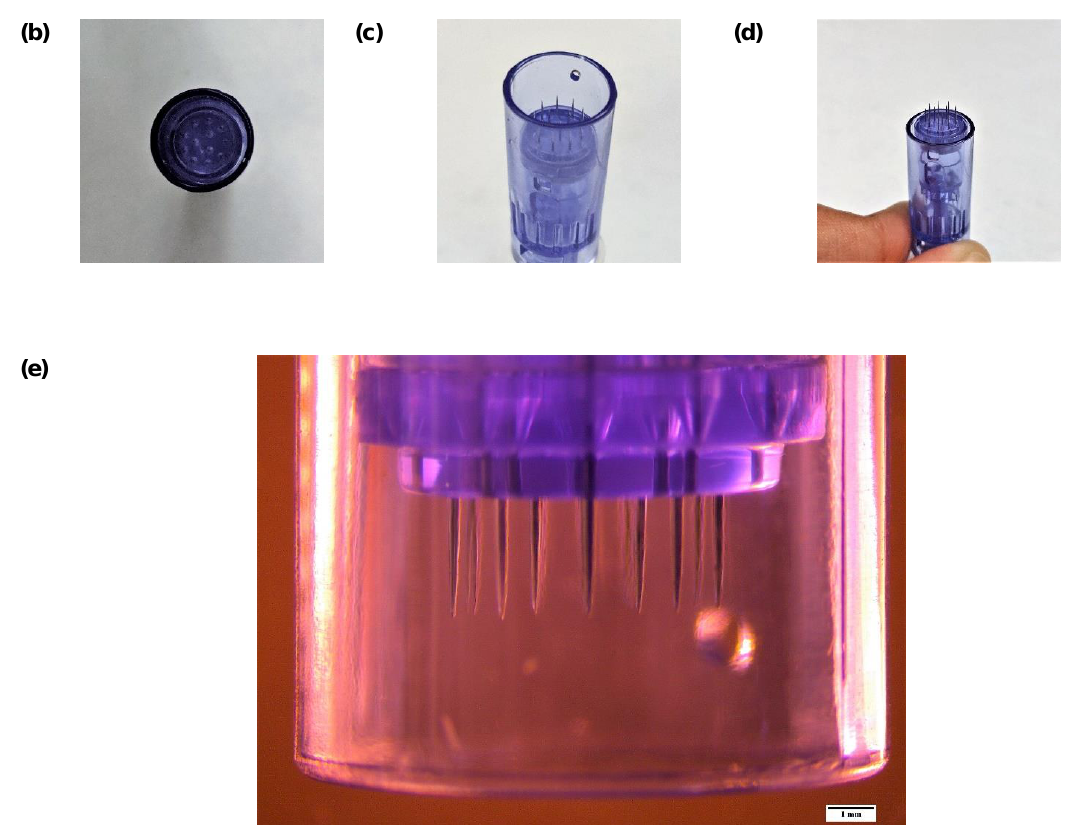
Figure 1. Image of Dr. Pen™ Ultima A6 with (a) description of the various parts of the device, (b) a top view of the cartridge displaying the arrangement of 12 microneedles and (c) a side view of the cartridge with the needles in the "off" position and (d) the needles pushed out of the cartridge at its maximum length. Image of (e) the cartridge visualized under a polarized light microscope. Scale bar represents 1 mm.